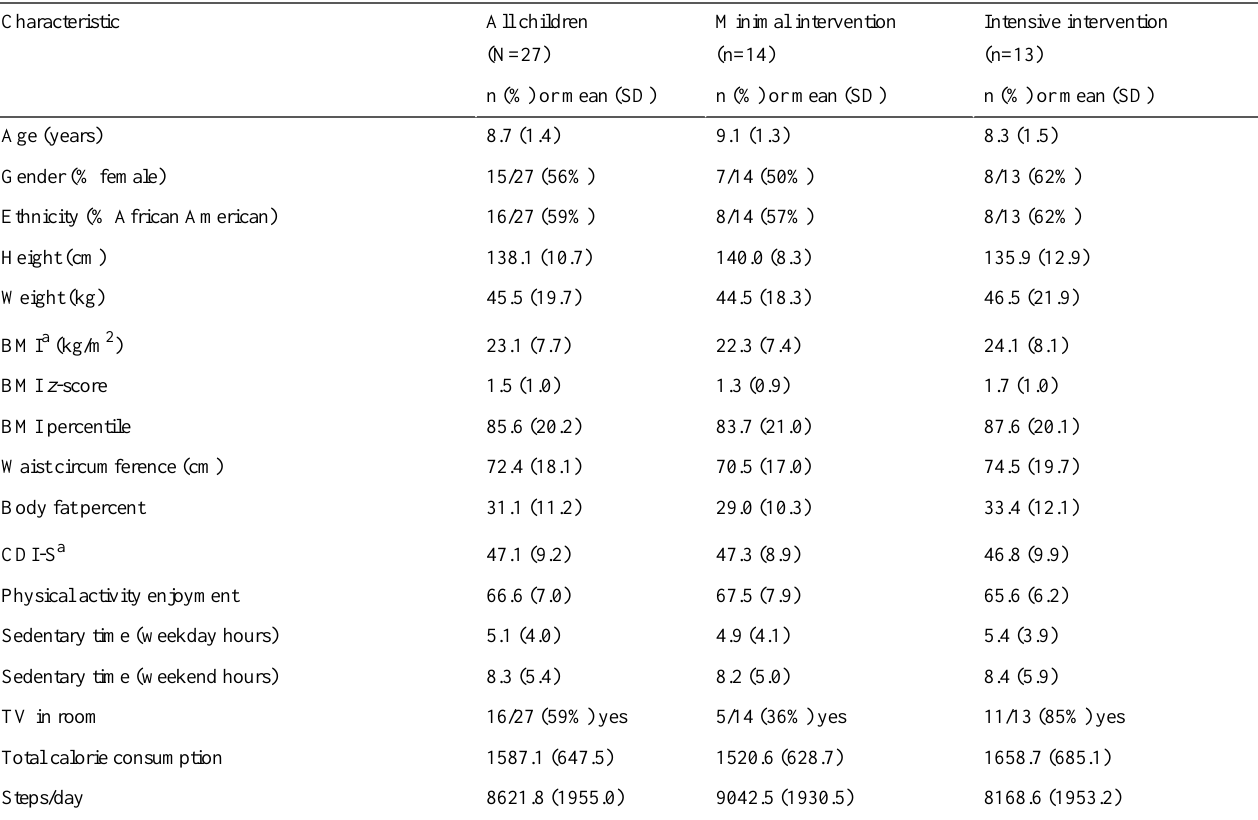
Table 3. Baseline demographic characteristics for all